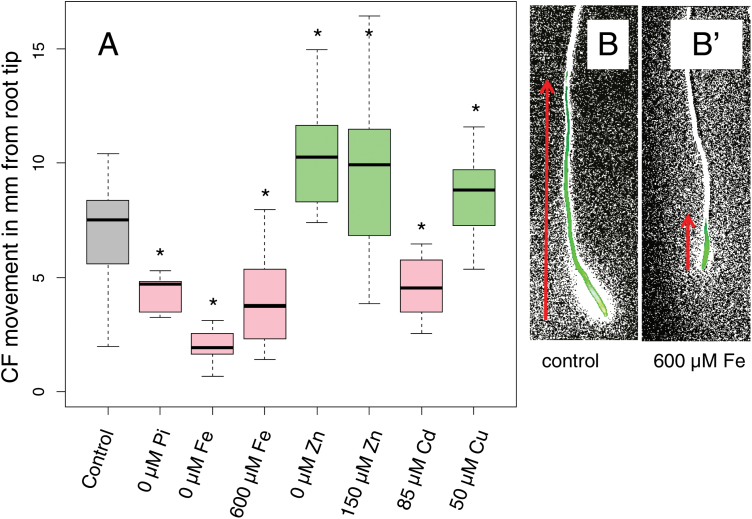
Changes in movement of CF after nutrient stress. (A) Distance of CF transport (from the root tip shootwards) in roots grown for 24 h under the treatment conditions indicated in the figure. For this assay, CFDA was micropipetted to the root tip and then incubated at room temperature for 5 min prior to imaging. Distance of movement was then measured as described in the Materials and methods on modified images using ImageJ. Green boxes indicate an increase in movement; pink indicates a decrease. A significant difference relative to control images is also indicated by asterisks (Wilcoxon rank sum test; P<0.05, n>24). (B, B'). Representative images of CF after a color threshold has been applied using ImageJ under (B) control or (B') 600 µM Fe. The red arrows indicate the direction and approximate extent of CF movement.